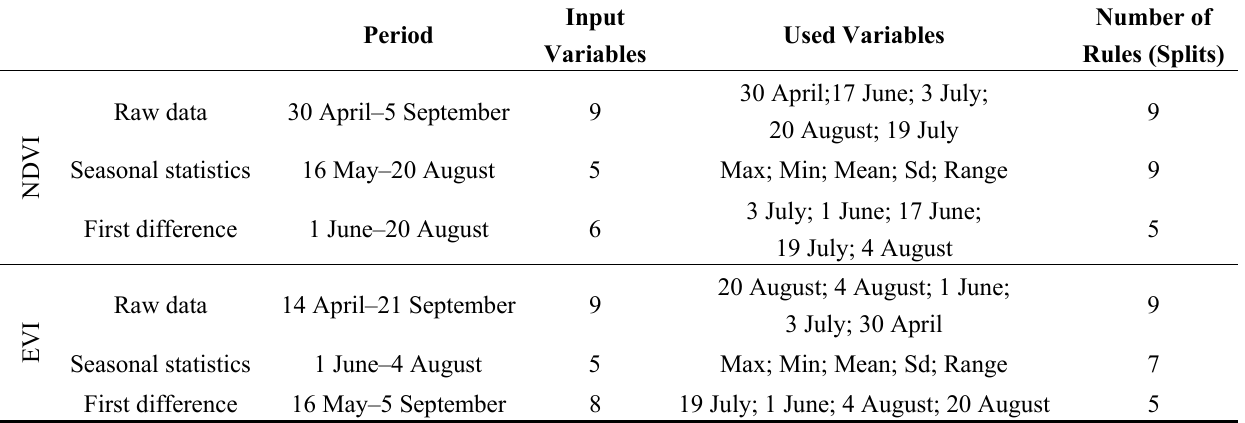
Table 9. Structure of the best case classification trees from the different data sets used.